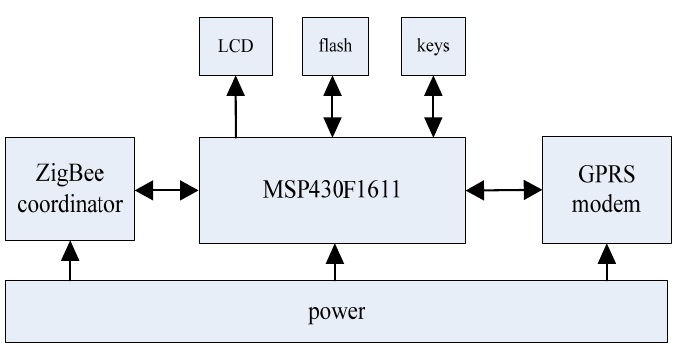
Figure 10. System hardware block diagram.